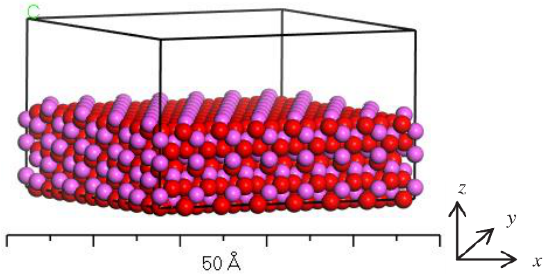
Figure 1. Model of Al 2 O 3 surface.